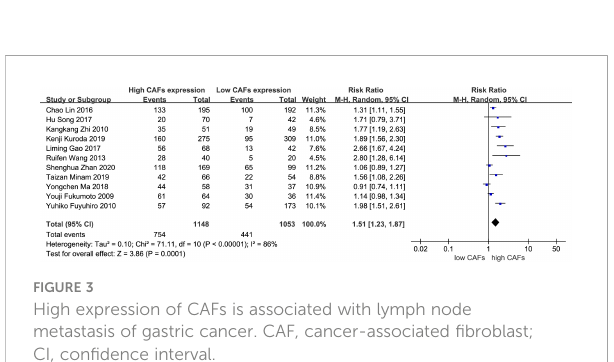
FIGURE 3 High expression of CAFs is associated with lymph node metastasis of gastric cancer. CAF, cancer-associated fi broblast; CI, con fi dence interval.